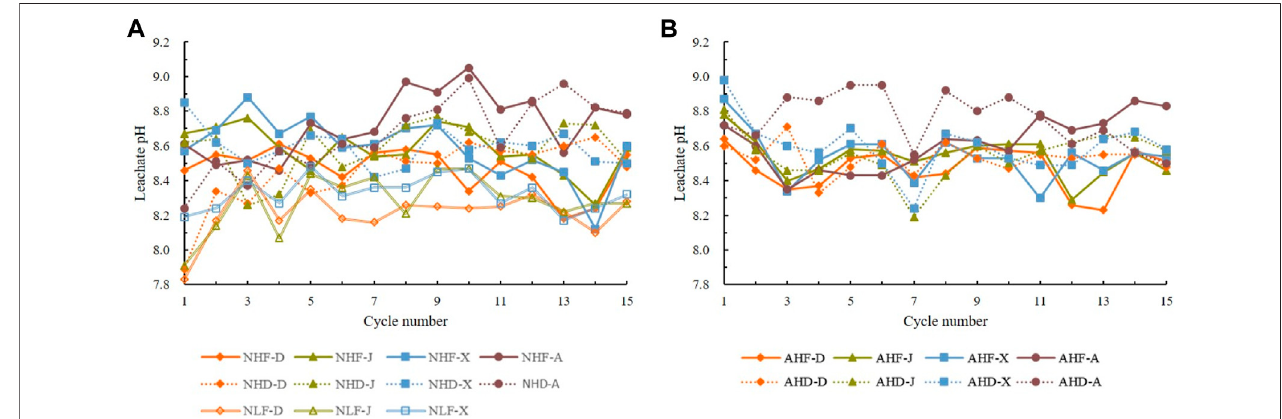
FIGURE 5 | Change of leachate pH over 15 cycles under (A) natural rain treatments and (B) acid rain treatments. Codes of treatments are N — natural rain and A — acid rain; H — high intensity and L — low intensity; D sample from Datang badlands, China; J sample from Jiangtian badlands, China; X sample from Xiahui badlands, China; A sample from Araguás badlands, Spain.